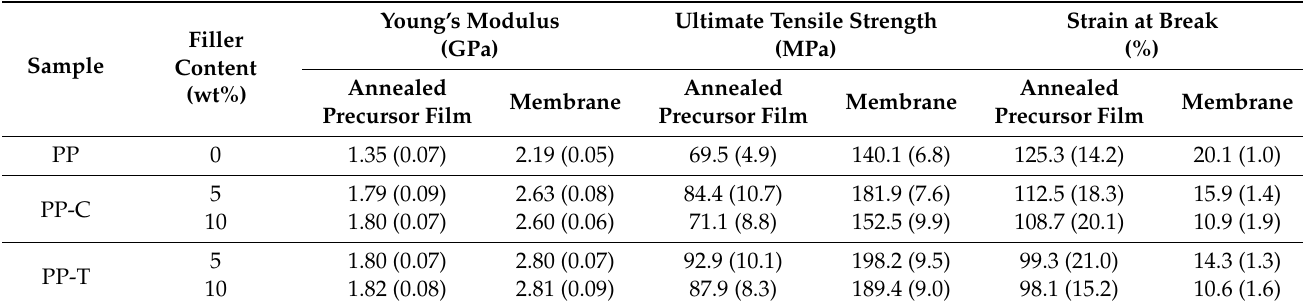
Table 4. Tensile properties of the annealed precursor films and membranes. Sample reference stands for outer layers. Standard deviation between